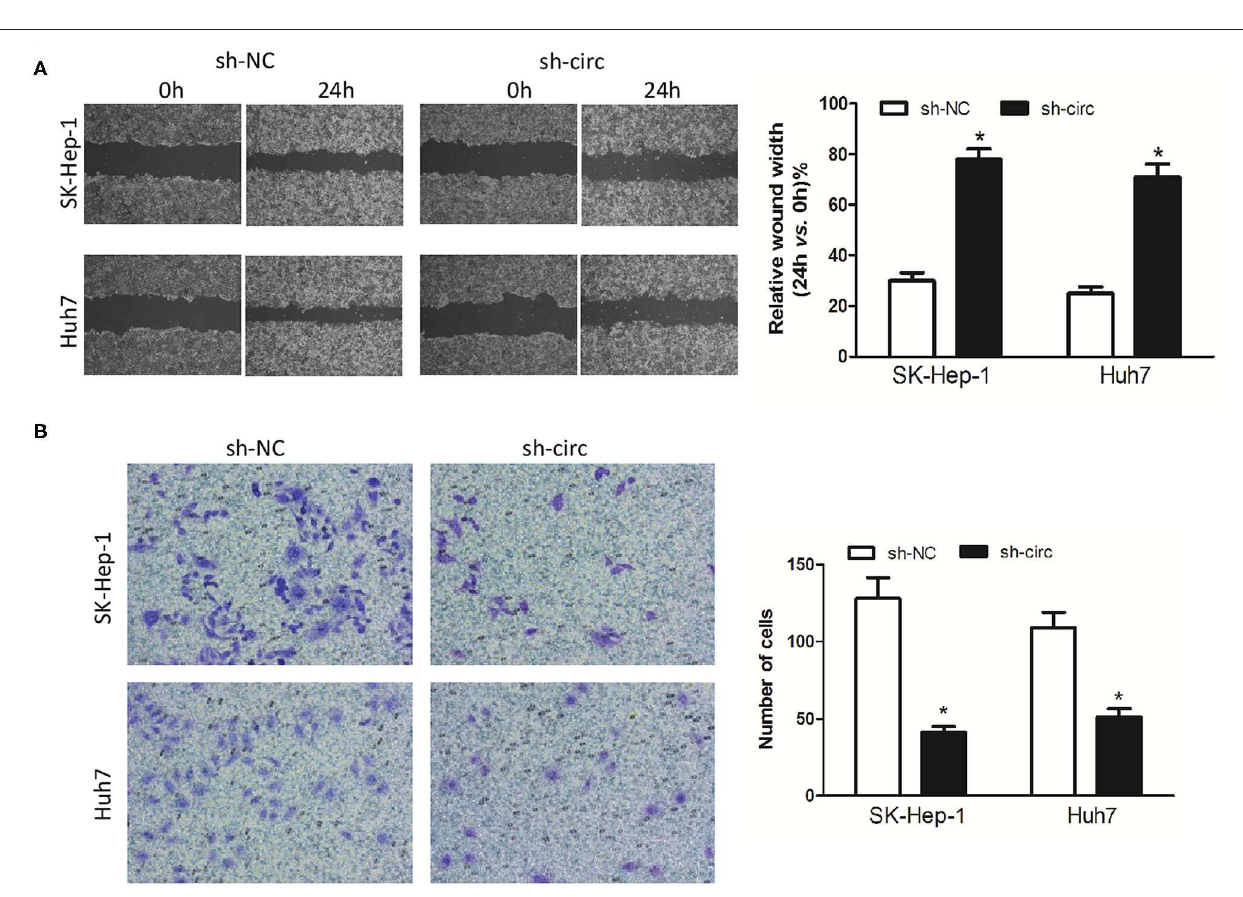
FIGURE 3 | Knockdown of hsa_circ_0005785 inhibits HCC cell metastasis in intro. (A) Cell migration activity was performed by wound healing assay in SK-HEP-1 and Huh7 cells after transfection with sh-NC or sh-circ. (B) Cell invasiveness was determined by Transwell assay in SK-HEP-1 or Huh7 cells after transfection with sh-NC or sh-circ, * P <